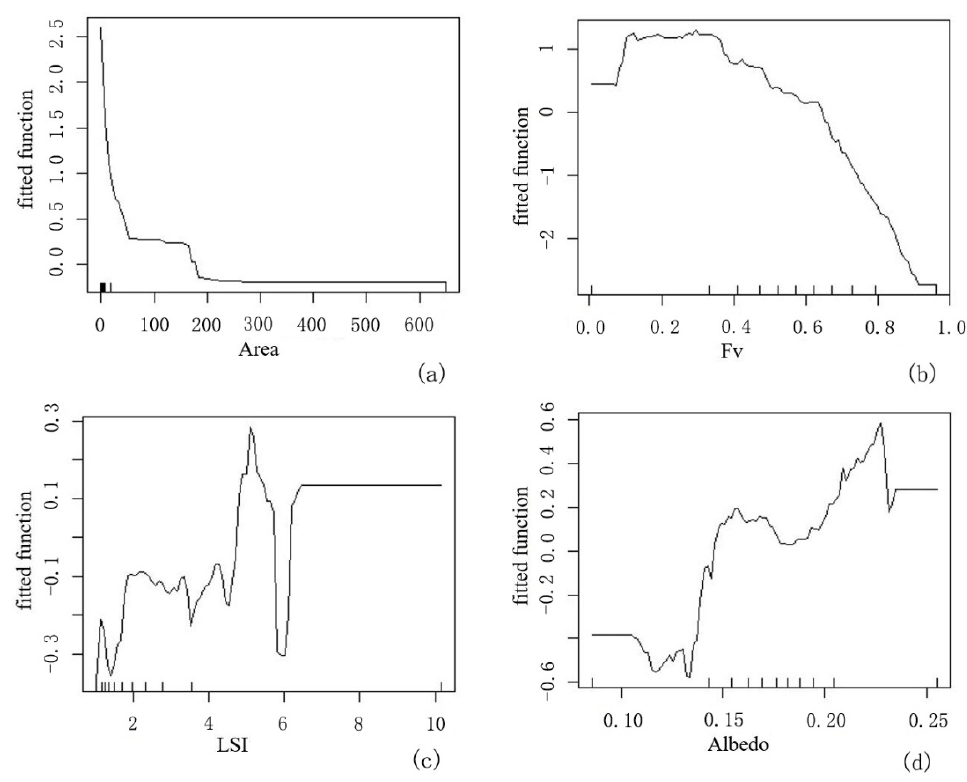
Figure 9. ME curve of morphological factors of greenspace on LST. ( a ) Fv of greenspace; ( b ) area of greenspace; ( c ) LSI; ( d ) surface albedo.